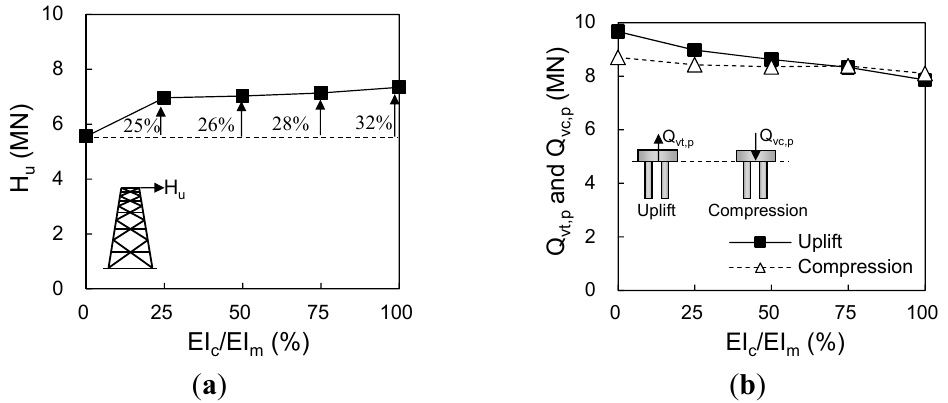
Figure 12. Load capacities of tower structure and connected foundation: ( a ) ultimate lateral load capacity of transmission tower ( H u ) and ( b ) transferred uplift ( Q vt,p ) and compressive ( Q vc,p ) loads.